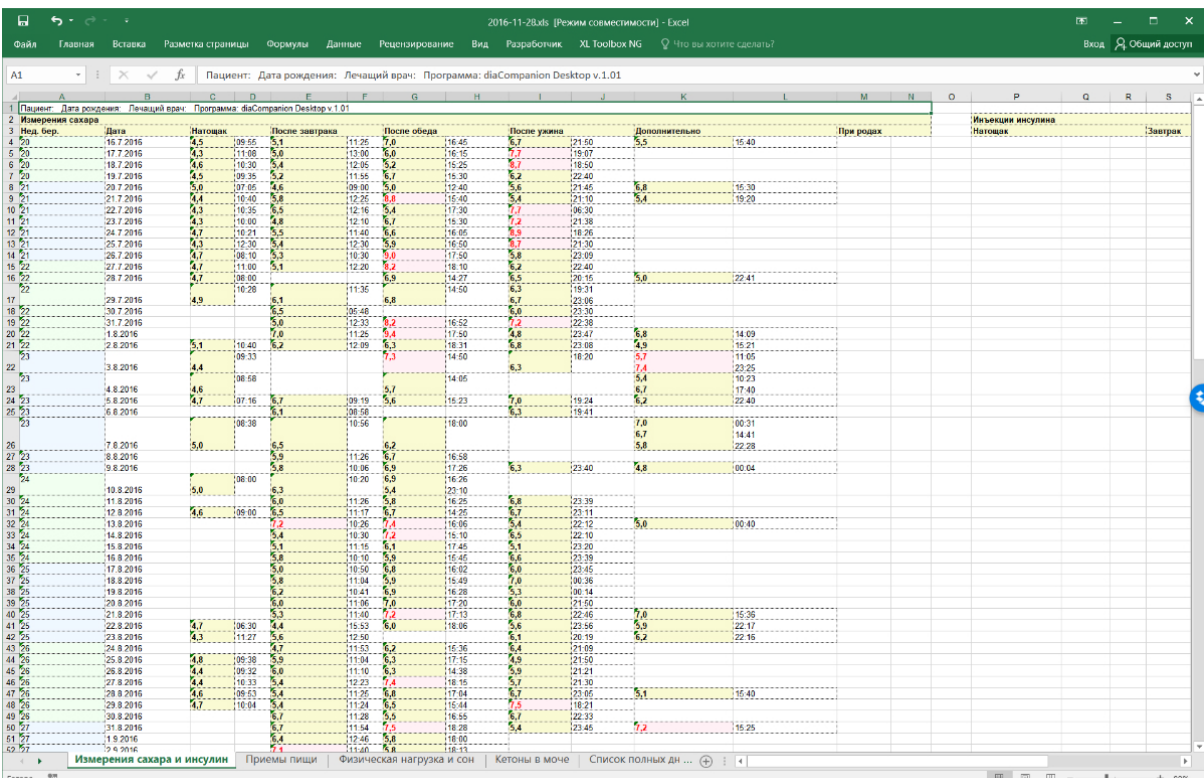
Figure 3. Example of a standardized report exported from the